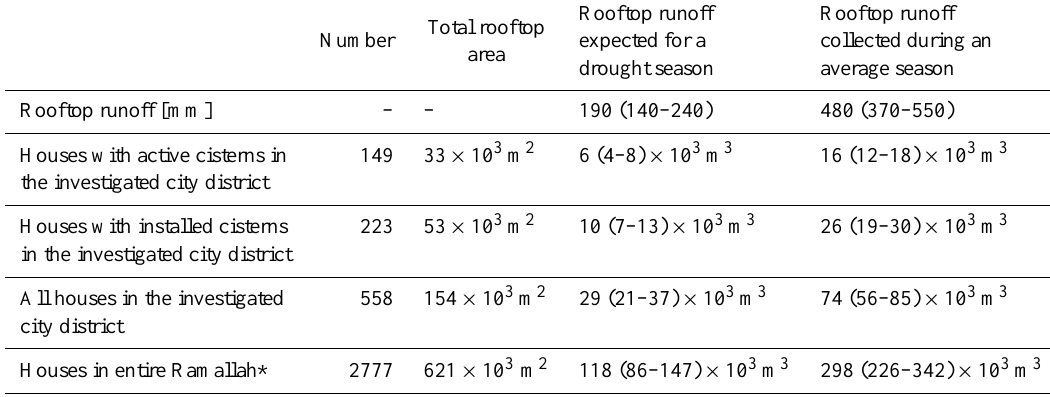
Table 1. Potentials for rooftop water harvesting in Ramallah; calculations are based on an orthophoto of 1997 and a questionnaire survey of 2000; uncertainty intervals are estimated by the 95% prediction interval of the RC-rainfall regression (Fig. 5).